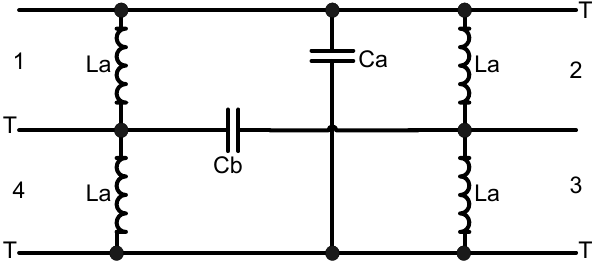
Figure 6. The equivalent circuit for the directional coupler with lumped elements